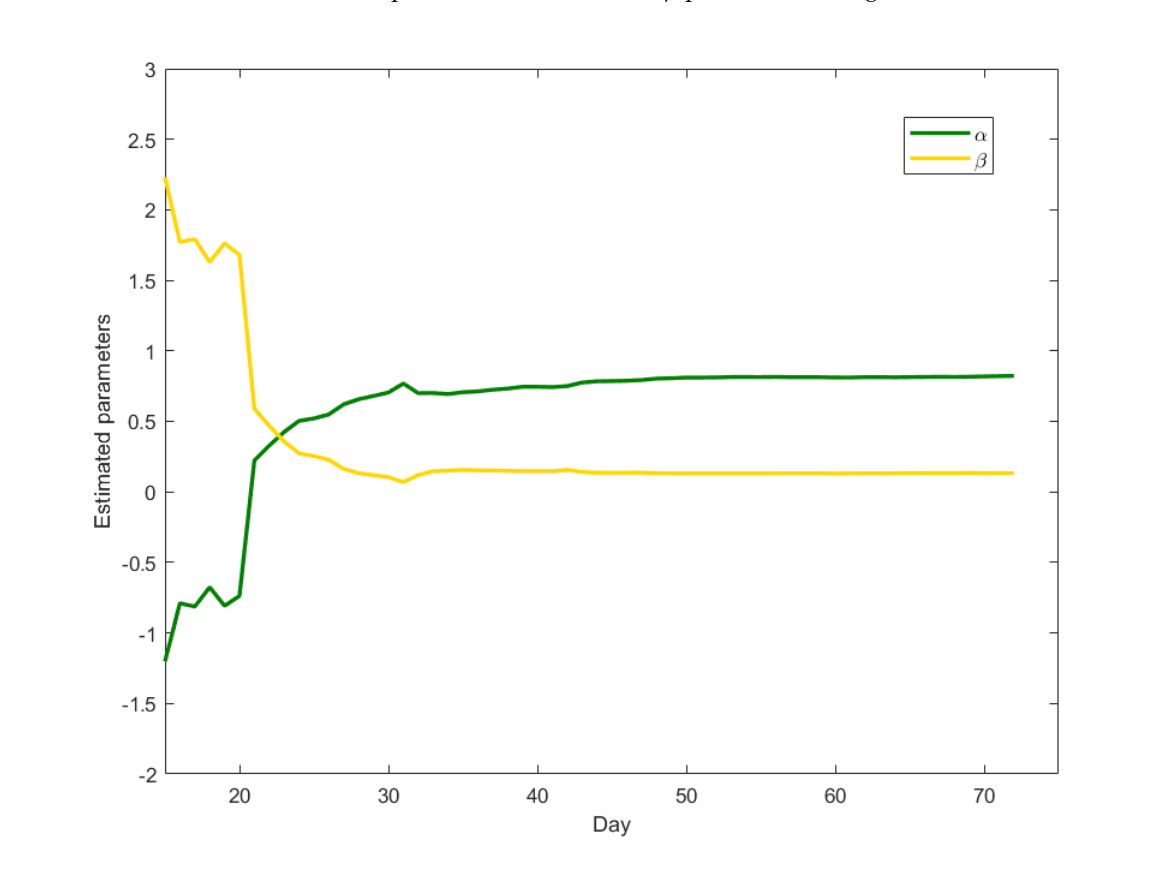
Figure 2. Evolution of the α and β parameters for Chinese daily infection